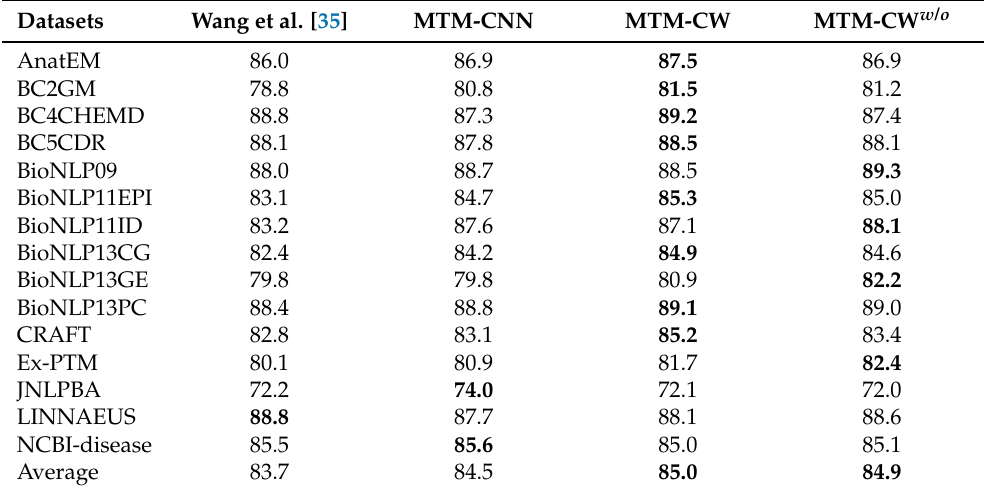
Table 5. Multitask models comparison where CW represents character and word, respectively.